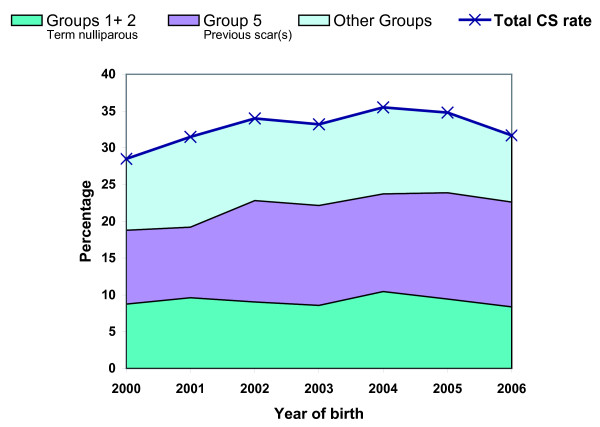
Contribution of selected groups to overall CS rate, KCMC, 2000-06.